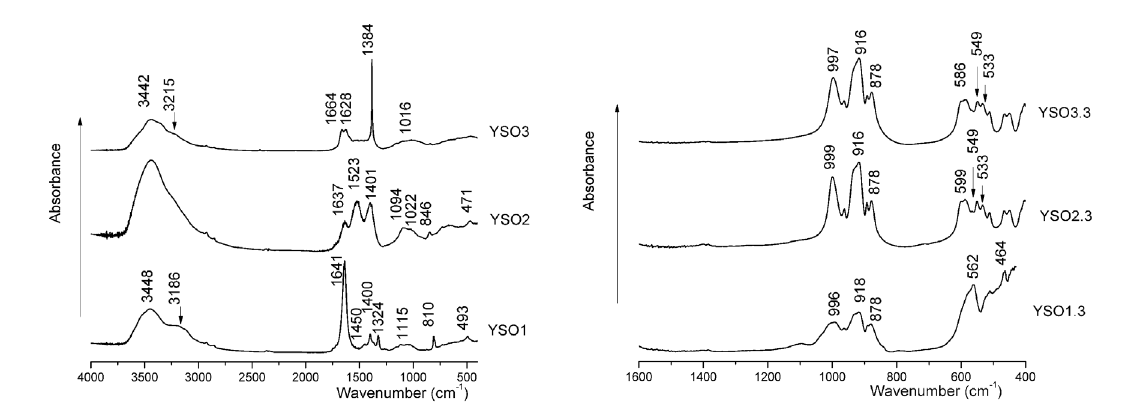
Figure 1. FT-IR spectra of precursors (left) and phosphors (right).